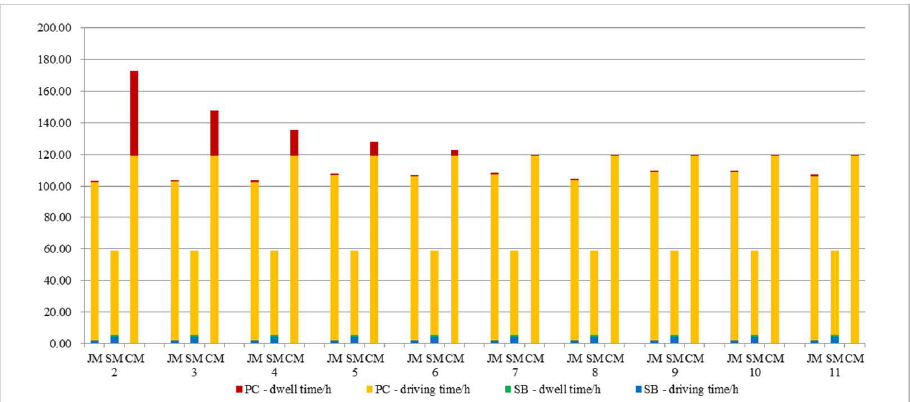
Figure 16. Various cost variations with parameter s .